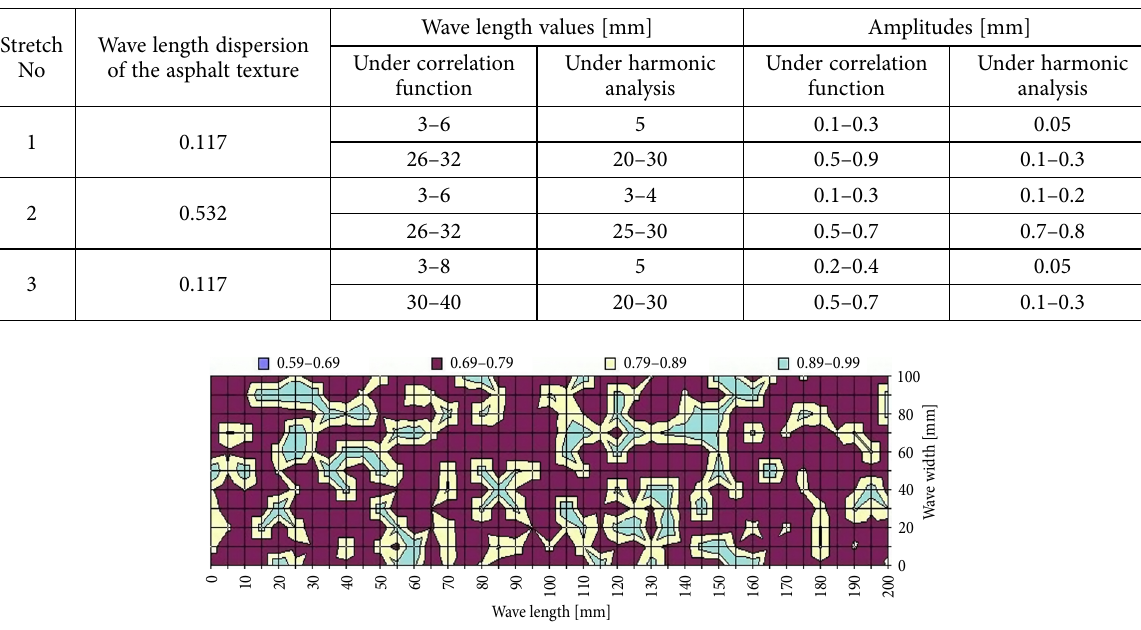
Fig. 7. View of road texture elements (intensity of colour denotes height above the median plane)